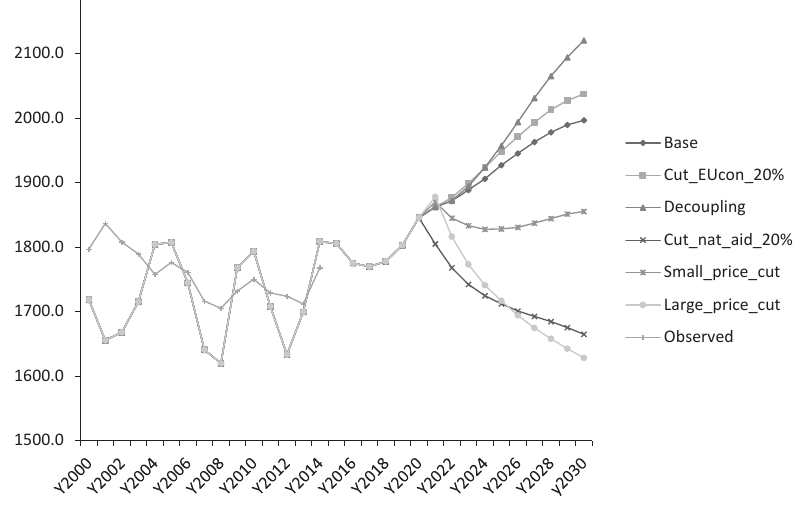
Fig. 5. Simulated milk production (million litres) 2000–2029 in different scenarios vs observed milk production 2000–2016 in the C support region (central and northern